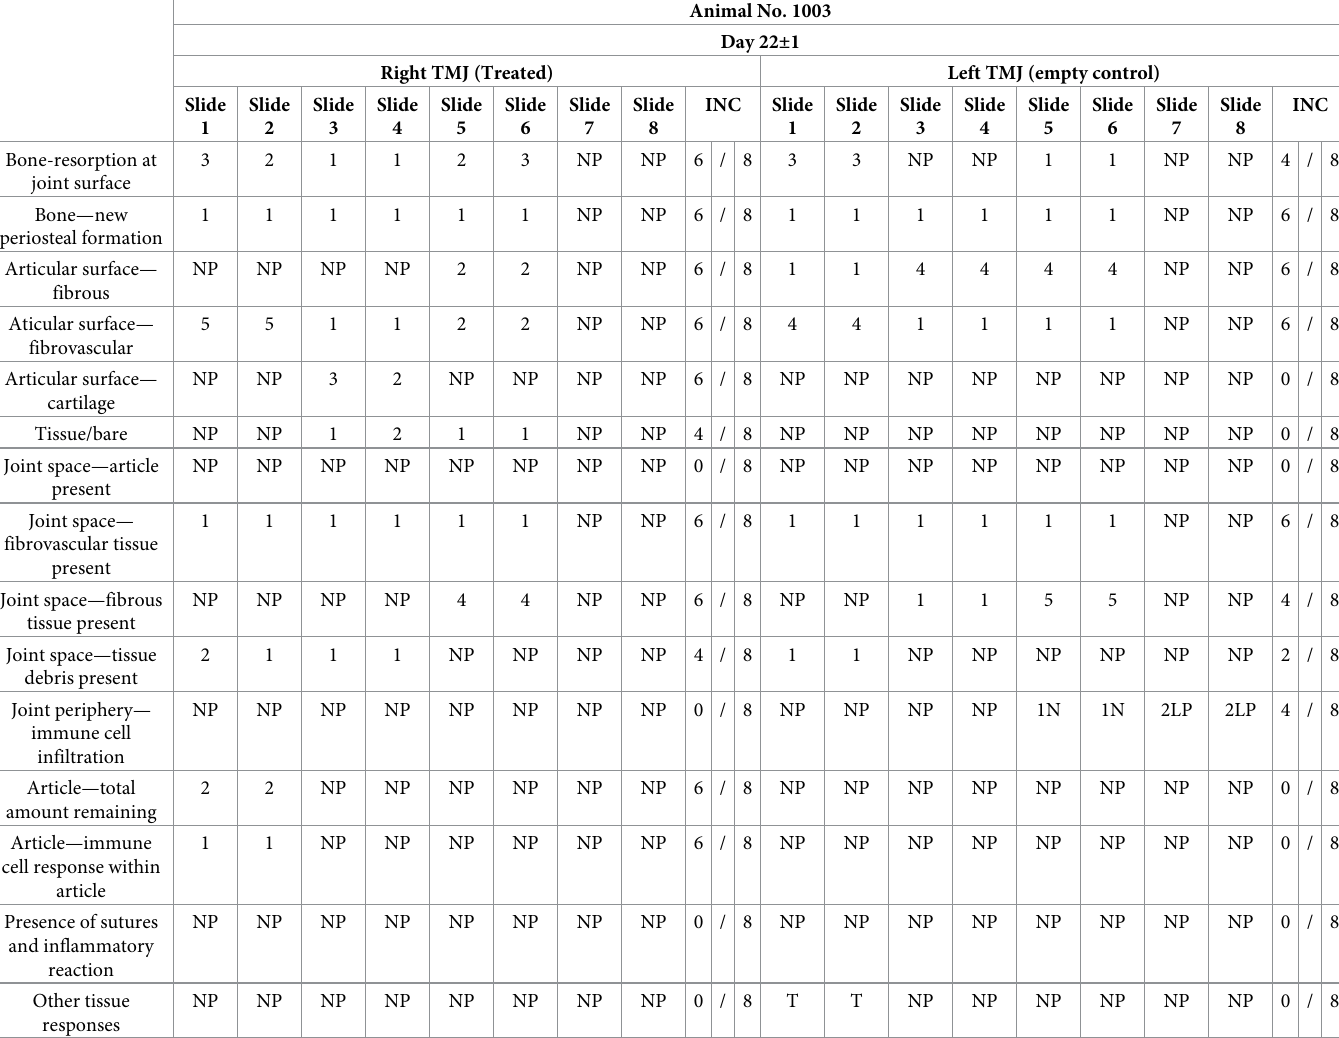
Table 10. Individual histopathological findings for animal